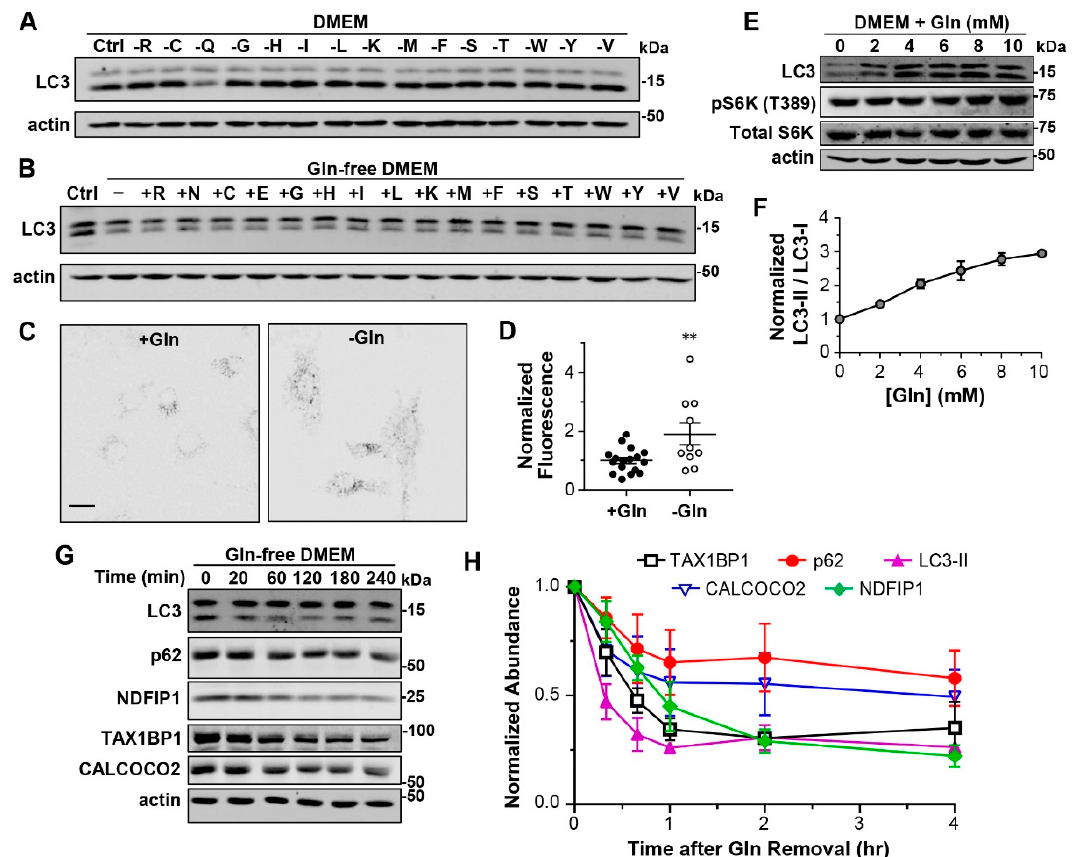
Figure 2. Glutamine is responsible for accelerating lysosomal degradation upon amino acid with- drawal. ( A ) Representative Western blot analysis of LC3 and actin of MEF cells subject to 1-h treatment in DMEM media omitting individual amino acids as indicated. Single-letter amino acid code is used. ( B ) Representative Western blot analysis of LC3 and actin of MEF cells that were treated for 1 h with Gln-free DMEM supplemented with 4 mM of the indicated amino acids. ( C ) Representative images of DQ-BSA-loaded MEF cells cultured in normal medium (+Gln) or subject to 1-h Gln star- vation (-Gln). Scale bar, 20 µm. ( D ) Statistics of fluorescence intensities of individual cells normal- ized to the mean of the +Gln controls. ** p < 0.01, by t test. ( E ) Representative Western blot analysis of LC3, pS6K (T389), total S6K, and actin in MEF cells treated for 1 h with DMEM containing indi- cated concentrations of Gln. ( F ) Concentration response curve of LC3-II/LC3-I ratios to Gln in the culture media, determined from n = 3 experiments as shown in ( E ). ( G ) Western blot analysis of LC3, p62, NDFIP1, TAX1BP1, CALCOCO2, and actin in BJ cells exposed to the Gln-free medium for dif- ferent time periods as indicated. ( H ) Statistics of LC3-II, p62, NDFIP1, TAX1BP1, and CALCOCO2 normalized to untreated BJ cells during 4-h time course of Gln starvation, from n = 3 experiments.